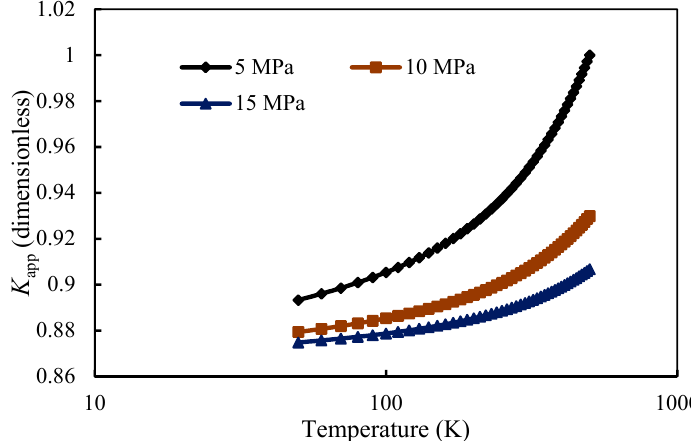
Figure 5. Relationship between temperature and dimensionless apparent permeability.